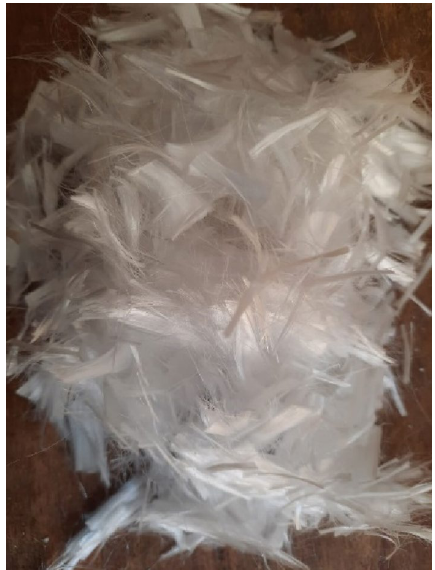
Fig. 1 PP fiber used in this work Fig. 2 Lightweight aerated autoclaved brick aggregates